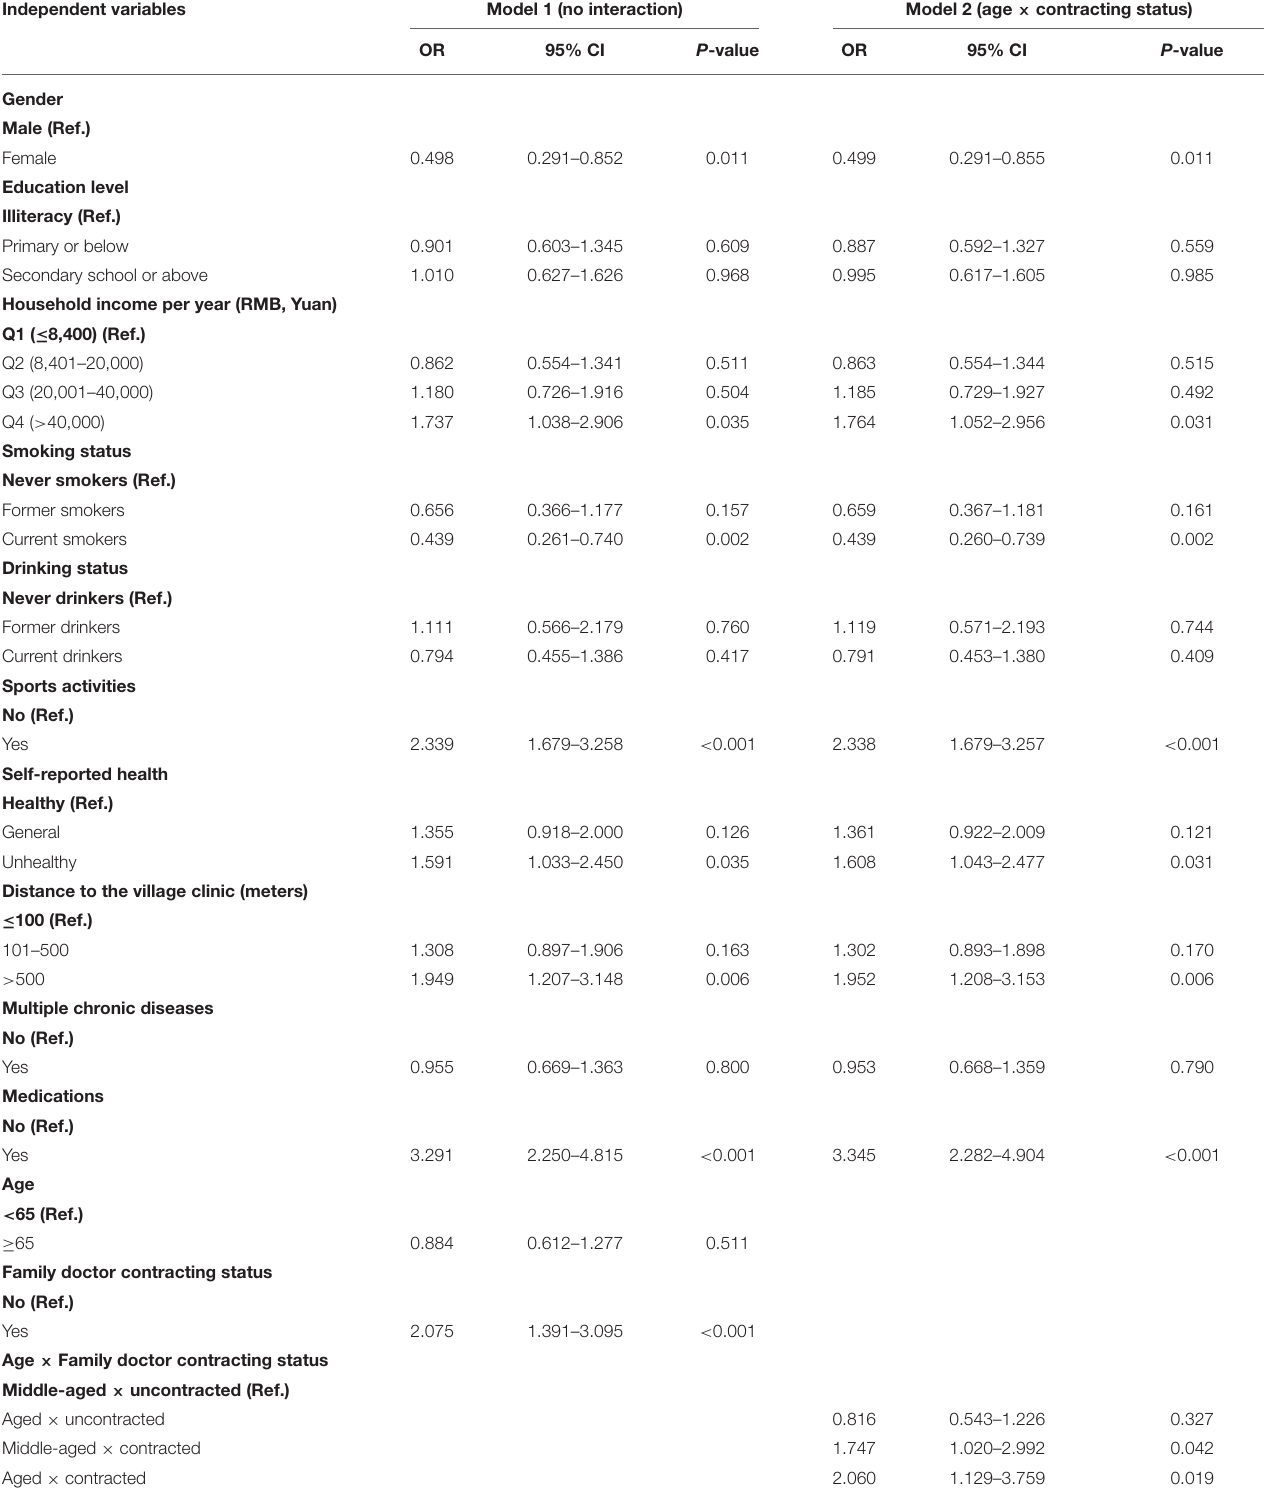
TABLE 3 | Logistic regression analysis of blood pressure measurement awareness among the hypertension patients in rural Shandong, China. Independent